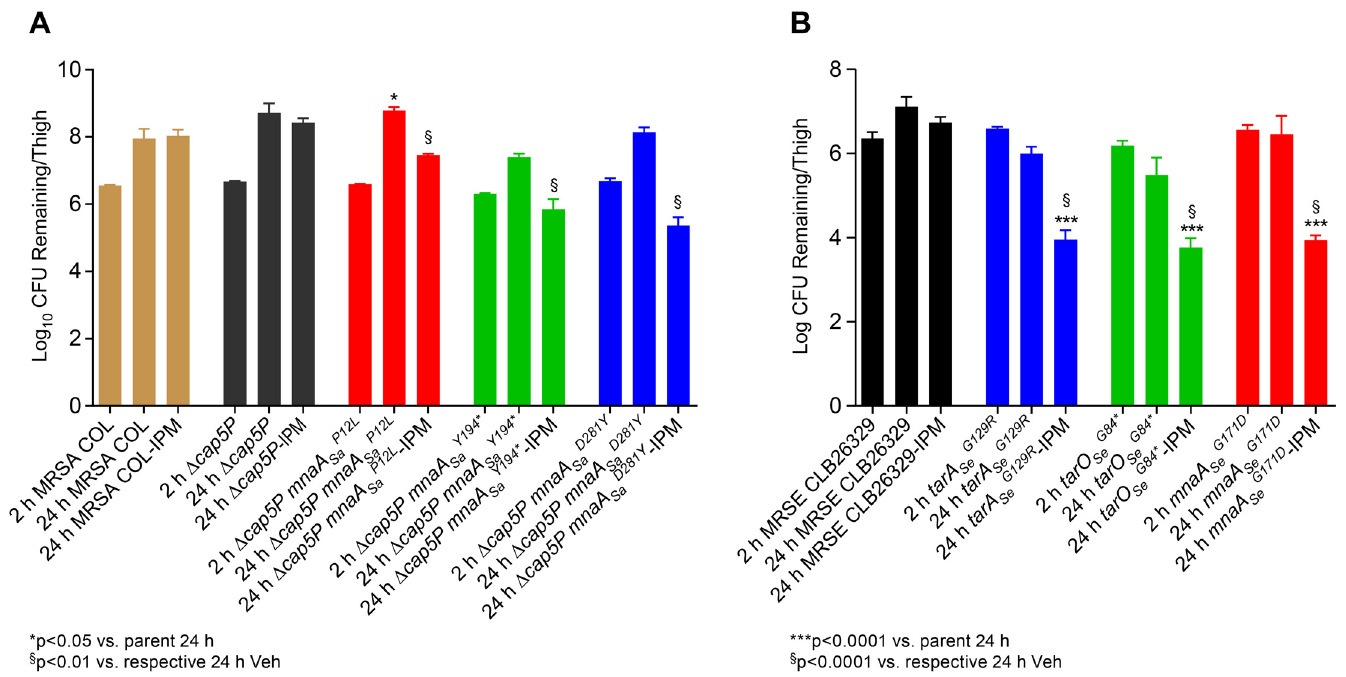
Fig 4. MRSA and MRSE MnaA LOF mutants are highly susceptible to imipenem in a murine thigh infection. Immune-suppressed CD-1 mice (5 per group) were challenged intramuscularly with the parental MRSA COL strain, MRSA Δ cap5P , or MRSA Δ cap5P mnaA Sa LOF mutants (A) or with the parental MRSE strain versus mnaA Se , tarO Se and tarA Se LOF mutants (B) and treated three times daily (TID) with imipenem (IPM). Thighs were harvested at 24hrs, homogenized and plated to determine CFU per thigh. (A) Restored efficacy of IPM (10 mg kg -1 ) against MRSA Δ cap5P mnaA SaP12L , Δ cap5P mnaA SaY194 * , and Δ cap5P mnaA SaD281Y . Following IPM treatment, bacterial burden amongst mice infected with Δ cap5P mnaA SaP12L , Δ cap5P mnaA SaY194 * , and Δ cap5P mnaA SaD281Y is reduced approximately 2 – 3 log at 24 hrs versus those infected with MRSA COL or Δ cap5P controls. * p < 0.01 versus parent at 24 hr; $ p < 0.05 versus respective 24 hr vehicle. (B) Restored efficacy of IPM (2.5 mg kg -1 ) against MRSE mnaA , tarO , and tarA LOF mutants. Reduction in bacterial burden of mice infected with the mnaA SeG171D is comparable to those infected with tarO SeG84 * or tarA SeG129R mutants, yielding an approximate 3 log reduction in 24 hr IPM treatment versus the wild-type control. Note, as MRSE CLB26329 is more susceptible to IPM than MRSA COL, its dose was reduced to 4-fold versus the MRSA efficacy study